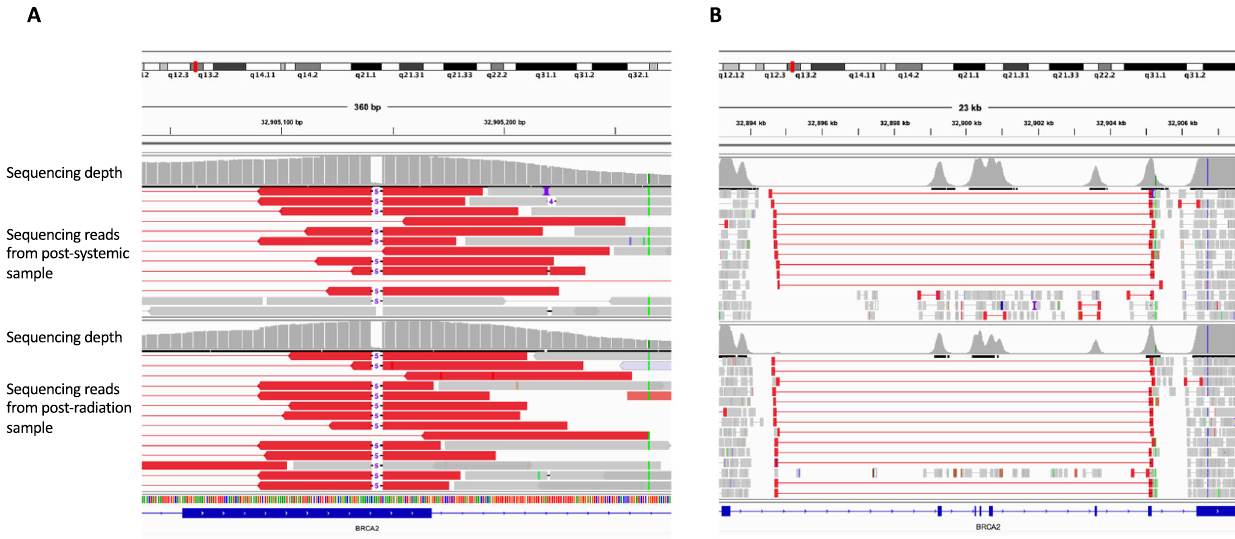
Fig. 5 Integrative Genomics Viewer (IGV) screenshot showing the overlap between the reversion structural variant and the germline mutation in BRCA2 . Thin red lines show the length of the reads supporting the structural variant and thick red lines show the ends of the reads delineating the breakpoints of the structural variant. The thin black lines with a “ 5 ” in the middle demonstrate the germline 5 base pair deletion. The histograms above each sample ’ s reads show the depth of sequencing at that locus. A IGV screenshot showing the overlap between the end of the reversion structural variant and the germline short deletion in the post-systemic therapy sample (top) and post- radiation sample (bottom). B IGV screenshot showing the region of BRCA2 affected by the structural variant in the post-systemic therapy sample (top) and post-radiation sample